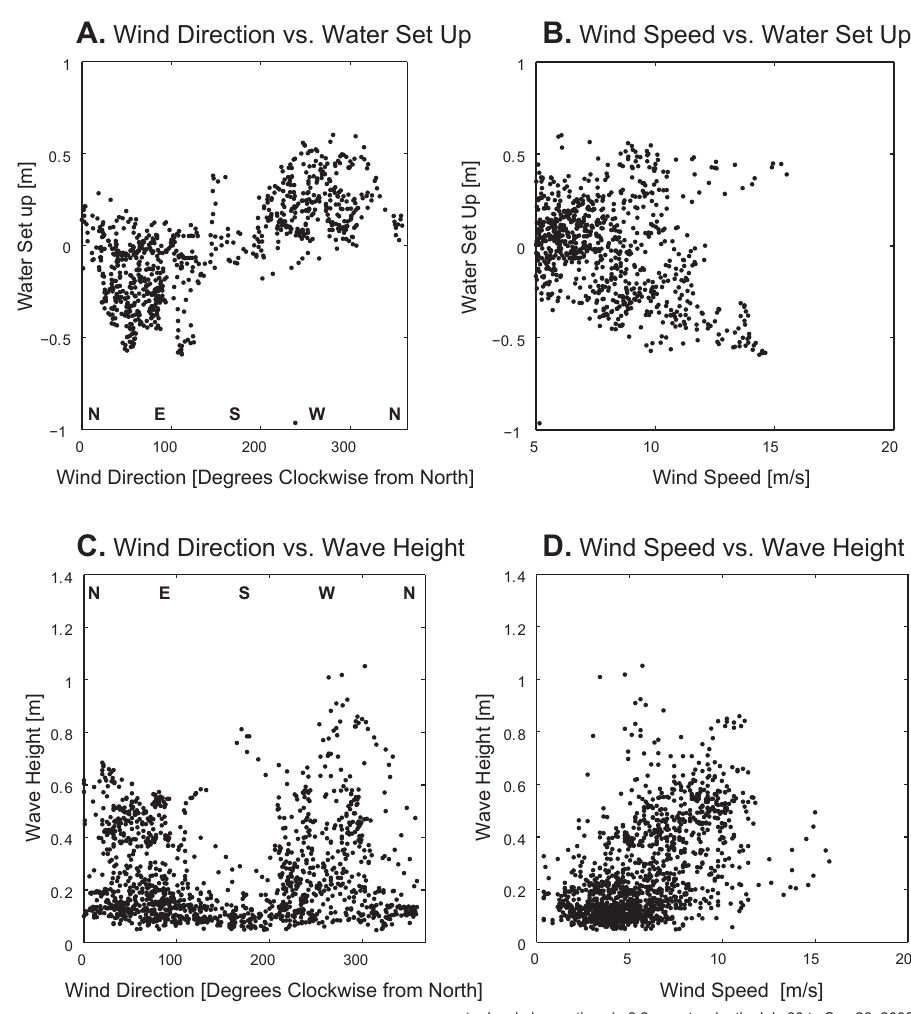
Figure 4. Relationship between wind field and nearshore conditions at Drew Point. Winds from the east set water levels down, whereas winds from the west set water levels up (a) . As wind speed increases, the magnitude of setup or set down is increased (b) . Wave height increases with wind from the east or west (c) and increases with increasing wind speed (d)